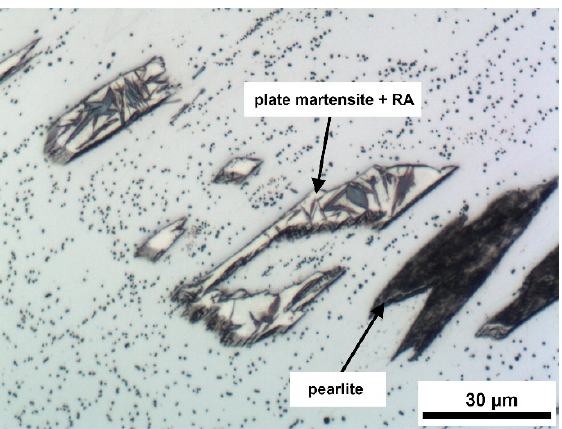
Figure 4. Transverse section of decomposed WA laths. Decomposition of WA laths: plate martensite + retained austenite or pearlite. Small WA particles remained stable in the final microstructure. LM.